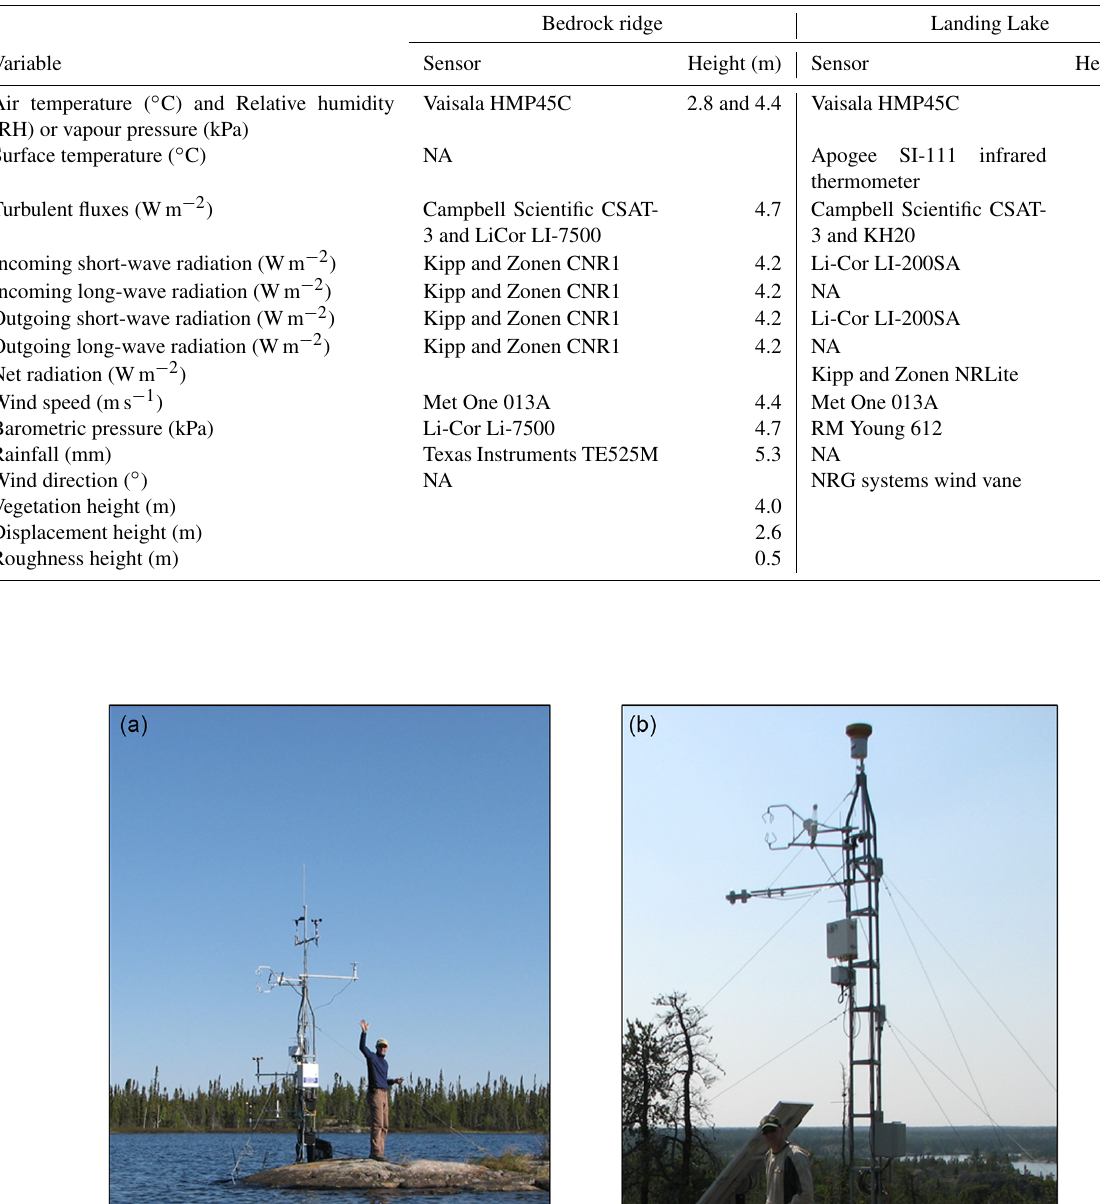
Table 4. Sensor suites at the primary climate stations at the bedrock ridge and Landing Lake. Vegetation height is the maximum observed at the bedrock ridge, with displacement and roughness height calculated with equations found in Oke (1987). NA – not available